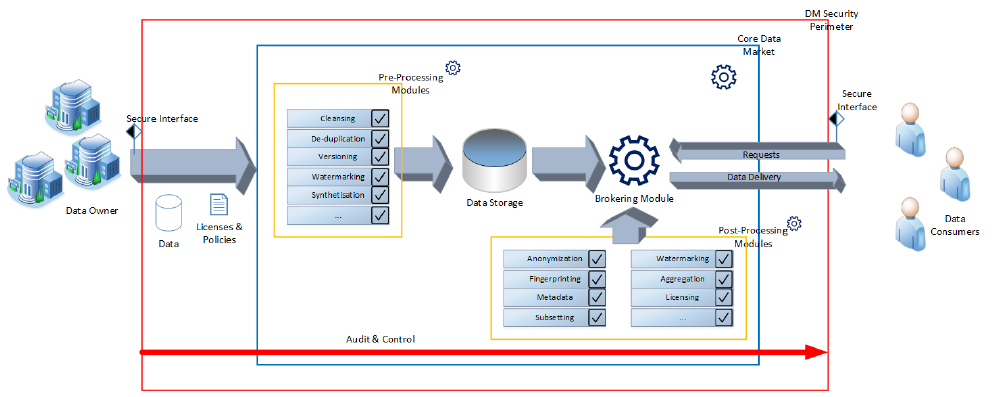
Figure 1. Generalised model